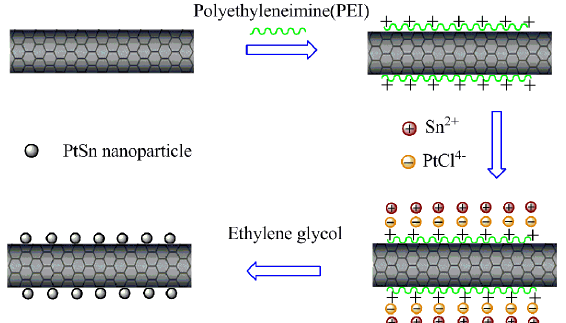
Figure 1. Schematic illustration showing the synthesis of PtSn electrocatalyst supported on polyethyleneimine ‐ functionalized multi ‐ walled carbon nanotubes (PEI ‐ MWCNTs).